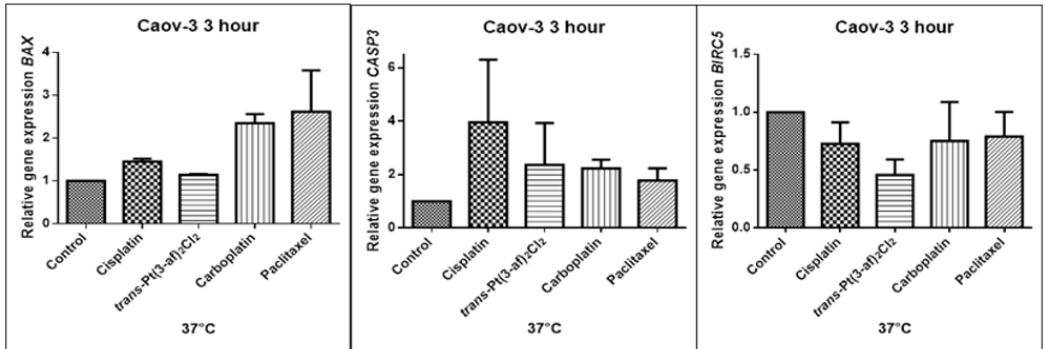
Figure 9. Level of gene expression of BAX, CASP-3, BIRC5 in ovarian cancer cells Caov-3. The gene expression level was presented as a relative value compared to a control equal to 1.